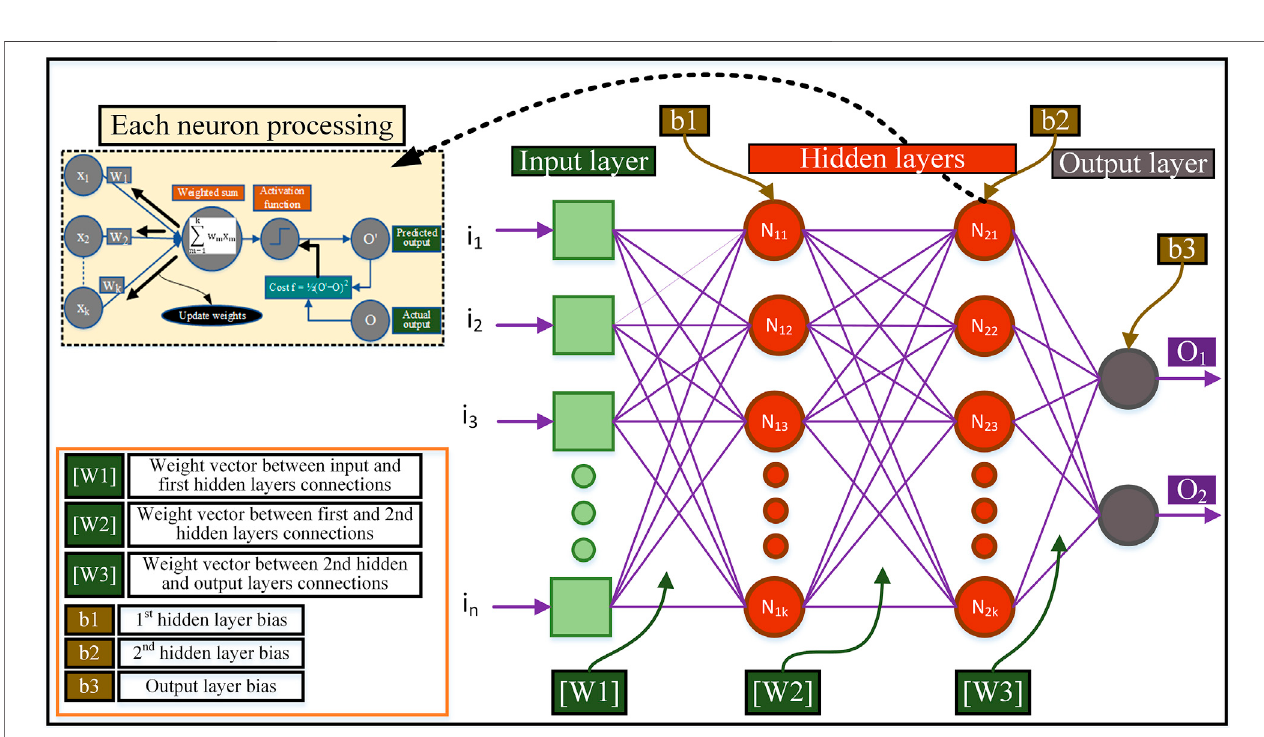
FIGURE 7 | Basic arti fi cial neural network architecture.